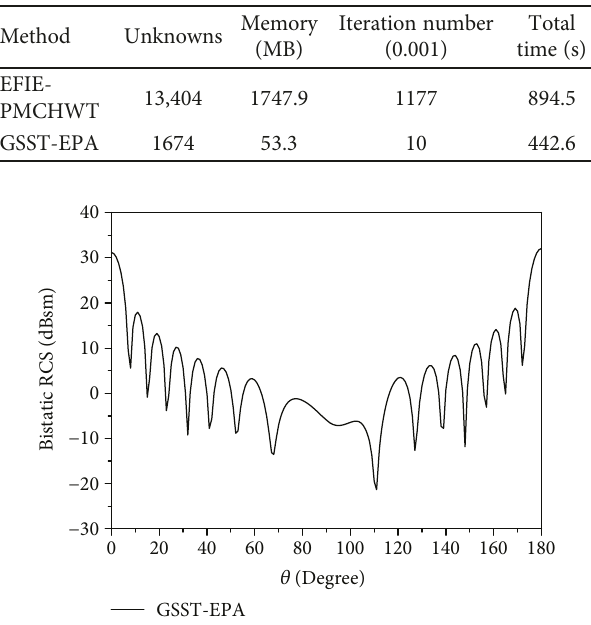
Figure 16: The bistatic RCS of a 15 × 15 bowtie antenna array at 1.0 GHz, HH